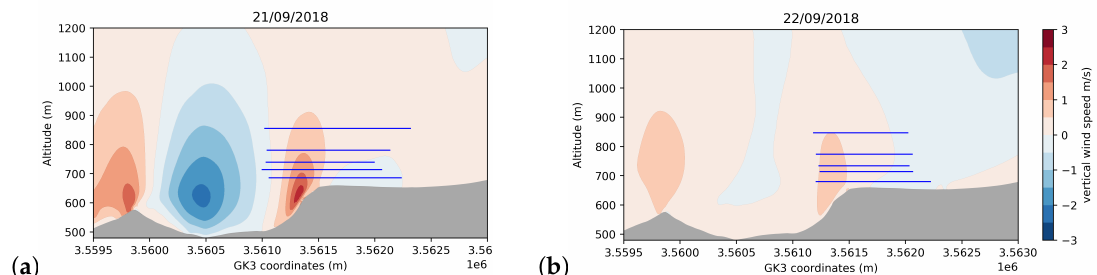
Figure 11. Cross-section of simulated vertical wind speed averaged over the whole flight duration on 21 ( a ) and 22 ( b ) September. The blue lines correspond to the legs plotted in Figures 8 and 10 performed by the